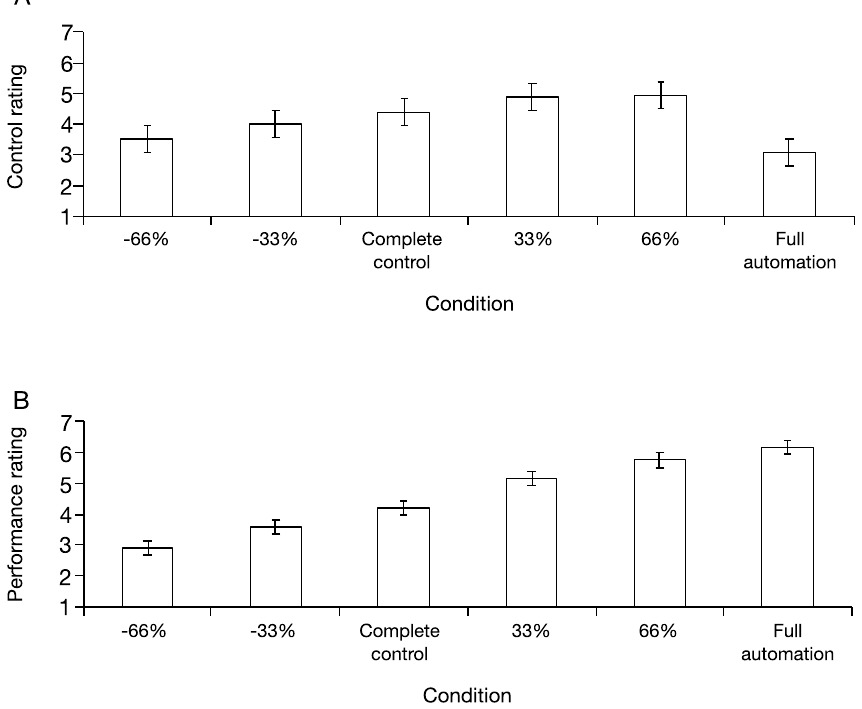
Figure 3. Average self-reported ratings for each condition. Statistical comparisons revealed that the full automation condition was significantly lower than the complete control condition in terms of control rating ( A ), but higher in terms of performance rating ( B ). The percentages − 66%, − 33%, “Complete control,” 33%, 66%, and “Full automation” denote the − 66% automation, − 33% automation, complete control, 33% automation, 66% automation, and full automation conditions, respectively. Error bars represent 95% within-subjects confidence intervals 39